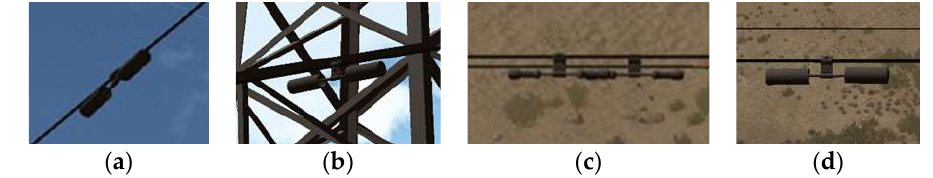
Figure 2. Virtual Samples: ( a ) Sky background; ( b ) tower background; ( c ) overlapping vibration-dampers; ( d ) ground background.